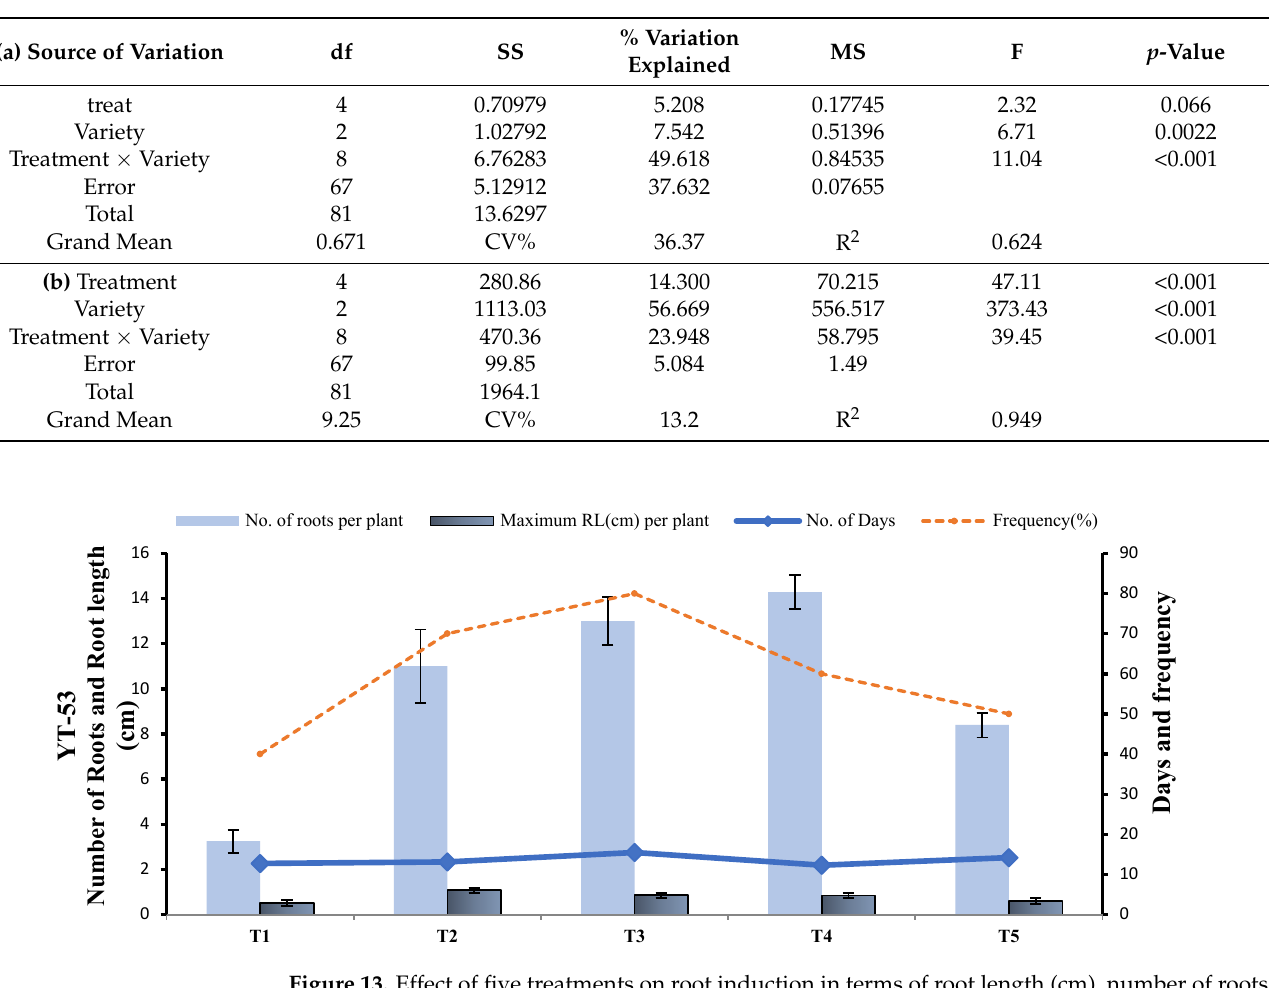
Table 6. Effect of treatments and genotypes on root length (a) and number of roots (b) during the rooting process.